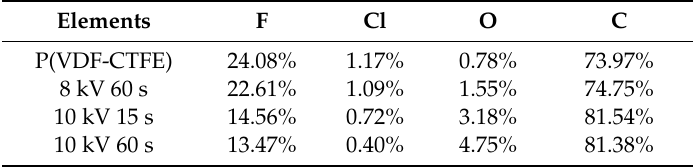
Table 2. The element content of P(VDF-CTFE) and the films treated by DBD.